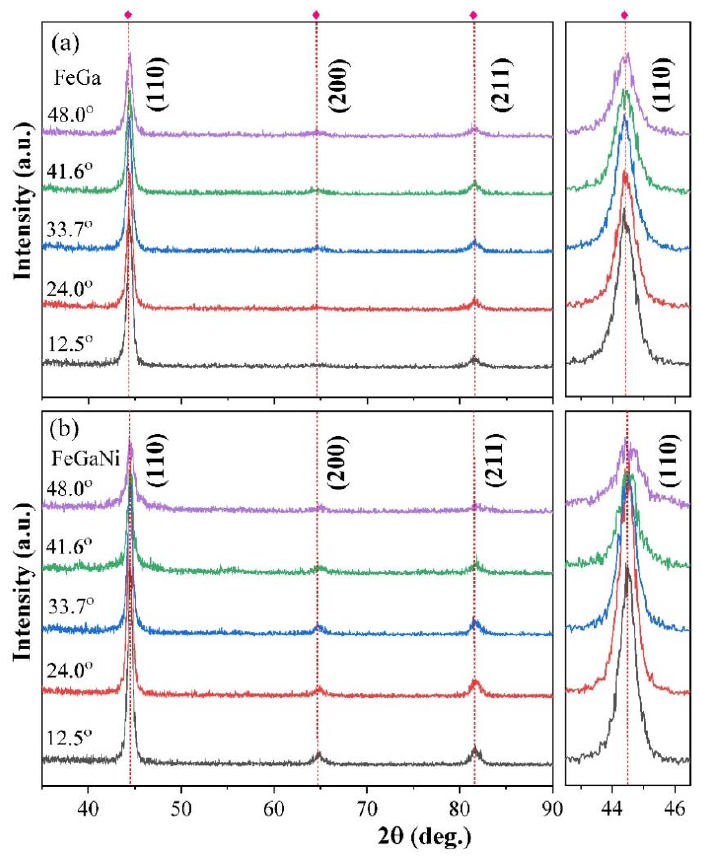
Figure 2. XRD spectra of FeGa ( a ) and FeGaNi ( b ) with increase in α . According to Scherrer’s formula and the full width at half-maximum (FWHM) of the (110) peak, for FeGa films, the crystallite size gradually decreases from 25.6 to 22.6 nm with increase in the α angle. This indicates that oblique sputtering can refine the crystallite size. While for FeGaNi, the crystallite size decreases from 28.7 to 17.1 nm with increase in α angle in Figure 3. When the α angle is smaller than 41.6 ◦ , the crystallite size of FeGaNi is larger than that of FeGa. In a larger α angle, the Ni content increases and plays the main part, which cause the crystallite size of FeGaNi to be smaller than that of FeGa. The compositions of the FeGaNi films were determined by EDX. As shown in Table 2, the EDX results show that the composition of Ni increases from 1.66% to 5.96% with the increase in α angle from 12.5 ◦ to 48.0 ◦ . With the low sputtering power of Ni target, the content of Ni in FeGaNi films is small. Meanwhile, from Table 2, the composition of Fe and Ga decreases from 84.75% to 82.75% and 13.59% to 12.3% with the increase in α from 12.5 ◦ to 48.0 ◦ , respectively. This is because, in the co-sputtering process, the distance between the substrate and two targets is different, which causes a varying sputtering rate and induces different proportions of elements in FeGaNi films with the position of substrate moving from left to right. Thus, the distance between the substrate and FeGa target increases with the increase in α , which causes a decrease in the Fe and Ga content in the films. In contrast, the distance between the substrate and Ni target decreases with the increase in α , which causes an increase in Ni content. However, the atomic ratio of Fe to Ga remains at approximately 6.2 with the increase in α angle in FeGaNi samples which is larger than that of FeGa target (the atomic ratio of Fe to Ga is 4). The result is coming from that the sputtering rate for a different element is very different in the sputtering process. The composition of Ni is much less than FeGa in FeGaNi films that the sputtering power of the Ni target is much less than that of FeGa target in the sputtering process. The magnetic properties of the FeGa film could be influenced by the crystallite size and the content of Ni doping.